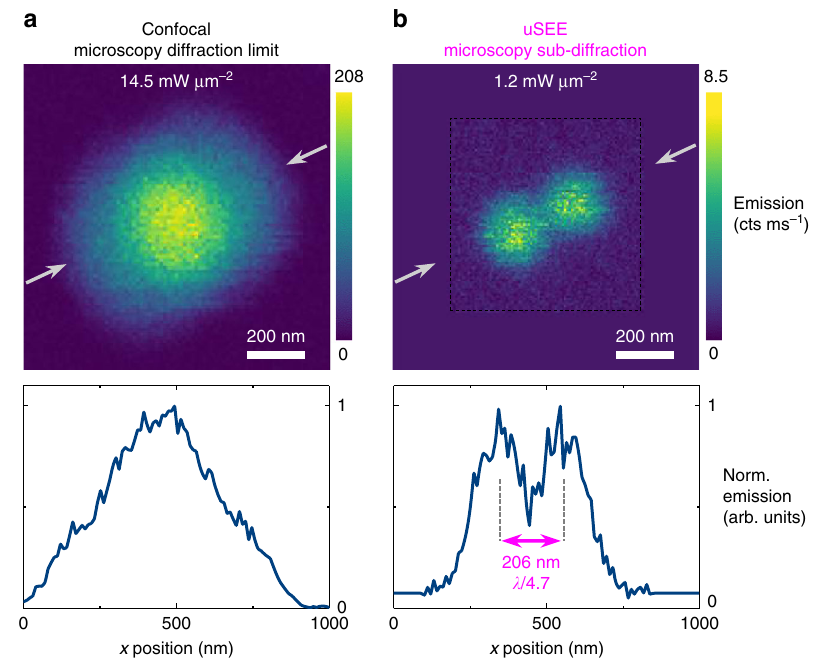
Fig. 2 Resolving two UCNPs at sub-diffraction distance via uSEE microscopy. a Imaging at diffraction-limited resolution does not differentiate the two UCNPs, separated by 206 nm. b uSEE microscopy resolves the two UCNPs. The line scans are obtained through a cross section indicated by the gray arrows. The dashed black box indicates the span of the experimentally measured area. The area outside of the black box contains a fl at background equal to the average background in the measured area. This facilitates the visual comparison of panels ( a , b